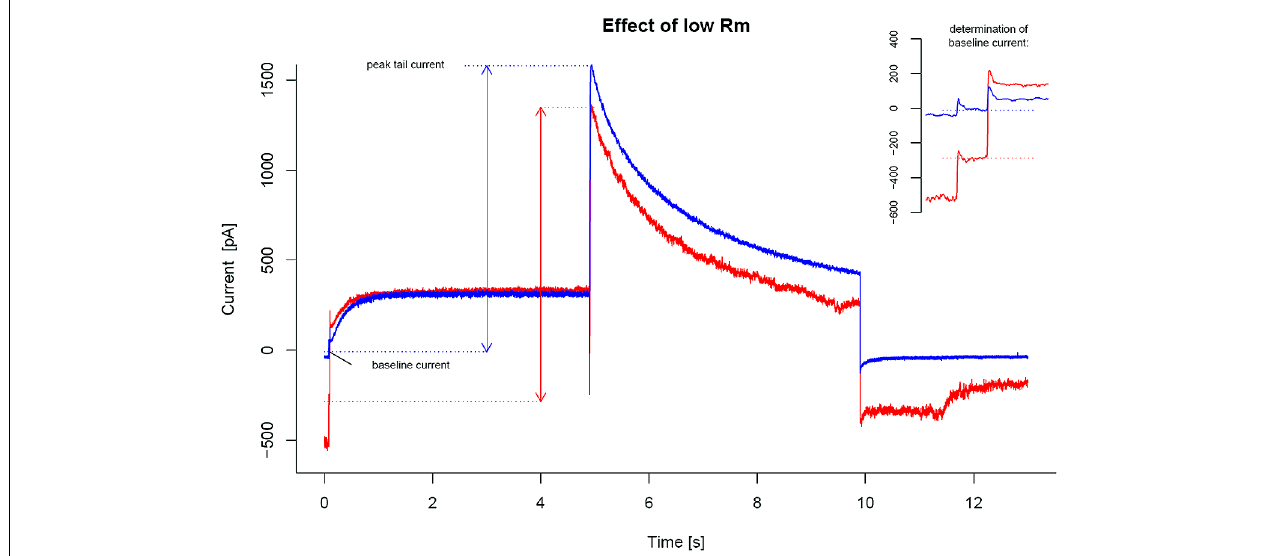
lines.The inset in the upper right corner provides a zoomed view on how the baseline current is determined during the baseline step. Due to the drop in Rm, baseline current and peak tail current are shifted to a comparable extent. The difference between baseline and peak tail current, indicated by the double headed vertical arrows, is more robust to changes in Rm than uncorrected peak tail current alone.